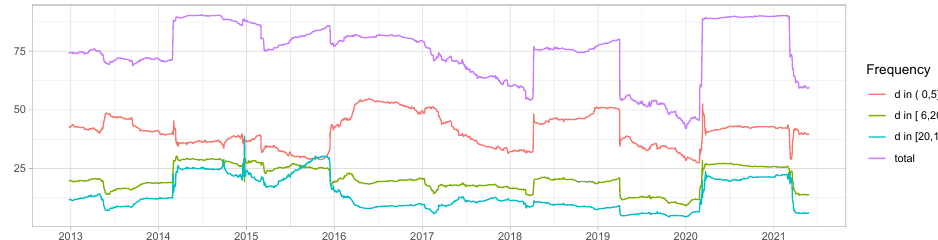
Figure 4. Dynamic frequency conditional connectedness. Two step approach.